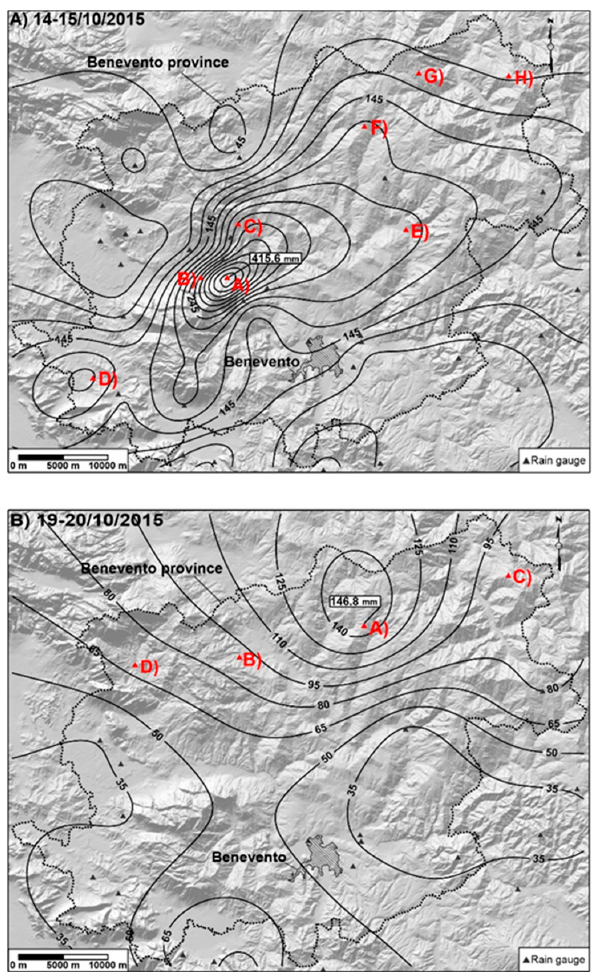
Figure 2. The spatial distribution of cumulative rainfall (black isohyets in mm) for ( A ) the event of 14–15 October (cumulative rainfall from 8:00 p.m. on 14 October to 3:00 p.m. on 15 October) and ( B ) the event of 19–20 October (cumulative rainfall from 11:00 a.m. on 19 October to 5:00 p.m. on 20 October). The maps label the registered maximum intensity, and the red triangles are the rain gauges selected for temporal analyses of the storms (Figures 3 and 4). The black triangles are the locations of rain gauges. The base map is a 20 m Digital Elevation Model (DEM, single-sided dimension).